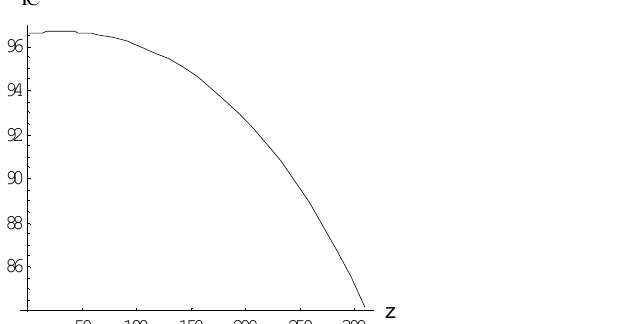
Fig.6.(b) The effect of parameter ζ on total cost in the fuzzy model